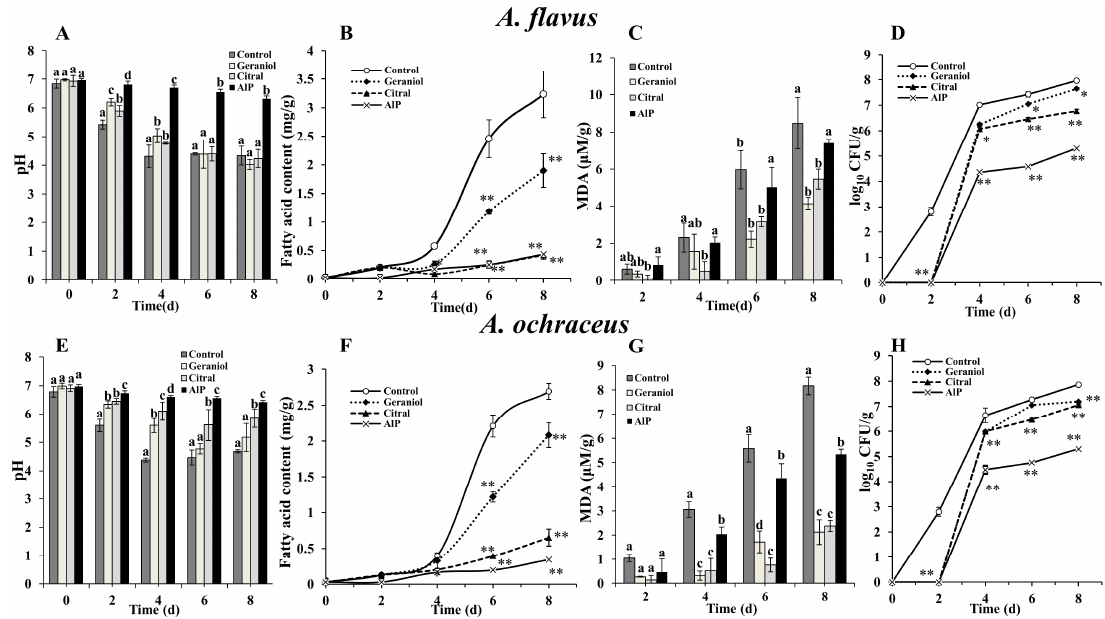
Figure 1. Effects of geraniol and citral on physiological qualities of rice infected by A. flavus and A. ochraceus . The grains were stored for various time intervals (0, 2, 4, 6, and 8 d) with geraniol (0.5 μ L/mL), citral (0.5 μ L/mL), and AlP (10 mg/L) treatment and sterile water (control), respectively. ( A ) Changes in pH values with A. flavus ; ( B ) Changes in fatty acid content with A. flavus ; ( C ) Changes in MDA content with A. flavus ; ( D ) Changes in colony number of A. flavus ; ( E ) Changes in pH values with A. ochraceus ; ( F ) Changes in fatty acid content with A. ochraceus ; ( G ) Changes in MDA content with A. ochraceus ; and ( H ) Changes in colony number of A. ochraceus . Data are the mean ± SD of three independent experiments. Different letters at each time point denote significant difference ( p < 0.05), and an asterisk ( p < 0.05) and two asterisks ( p < 0.01) are used when compared with control according to Duncan’s test.